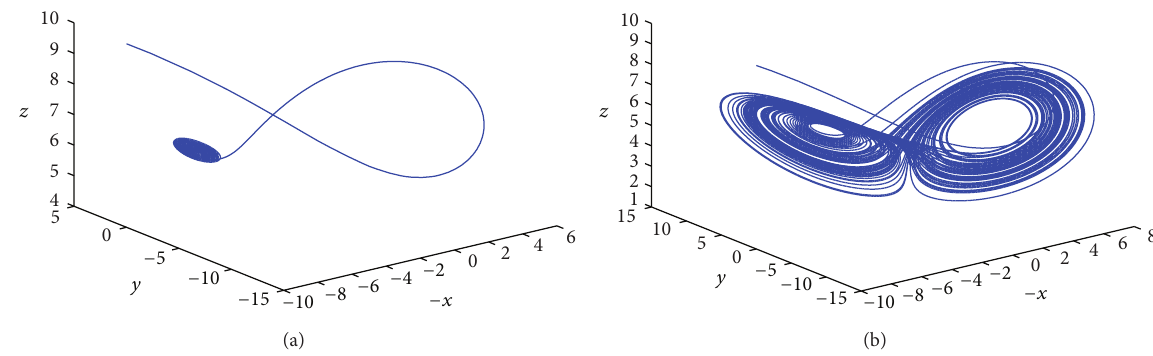
Figure 3: The phase portraits of 𝑥 - 𝑦 - 𝑧 for fractional Lorenz systems 𝛼 = 𝛽 = 𝛾 = 0.93 (left) and 𝛼 = 𝛽 = 𝛾 = 0.94 (right) for the case 𝑟 = 2 .